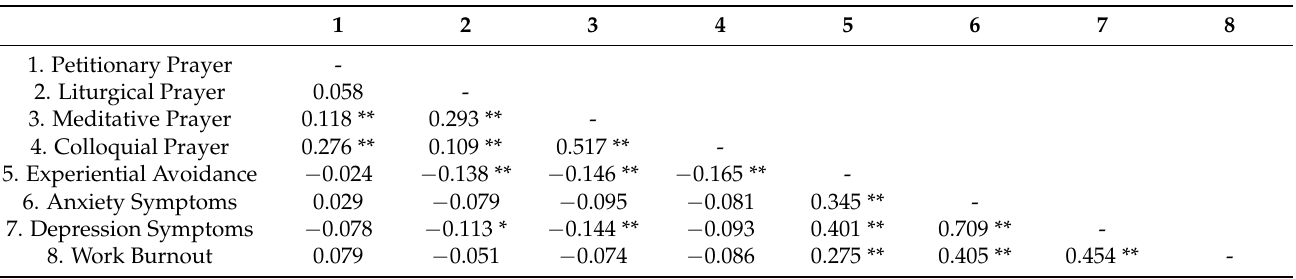
Table 2. Correlations among prayer types, experiential avoidance, and negative mental